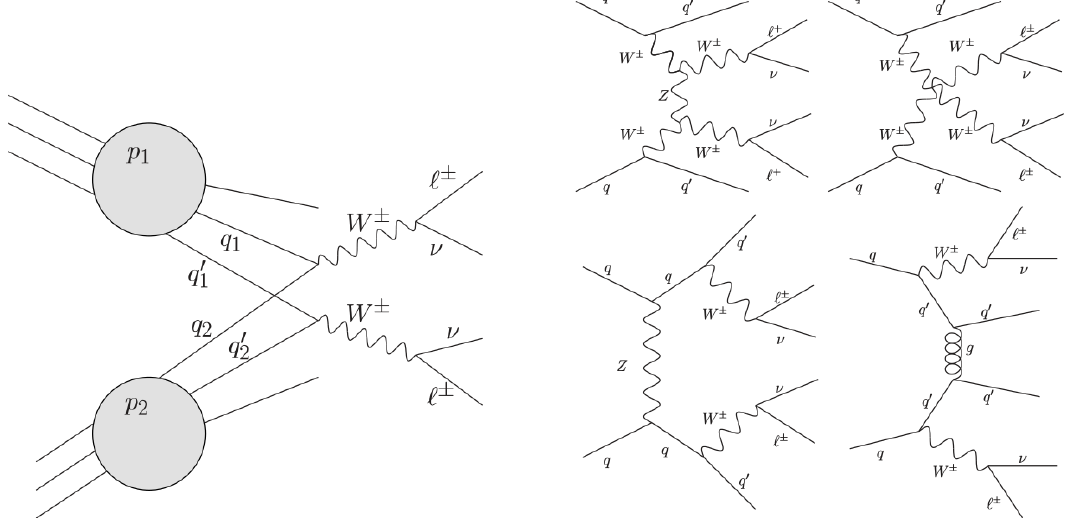
Figure 1 . Schematic diagrams corresponding to the production of a same-sign W boson pair via the DPS process (left) and via SPS processes